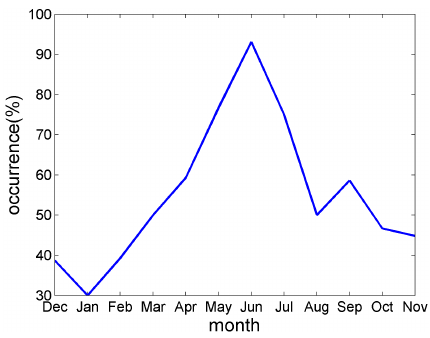
Figure 8. Monthly nocturnal occurrence rates of possible MSTID activity over Sanya during December 2011–November 2012 under geomagnetically quiet conditions ( P